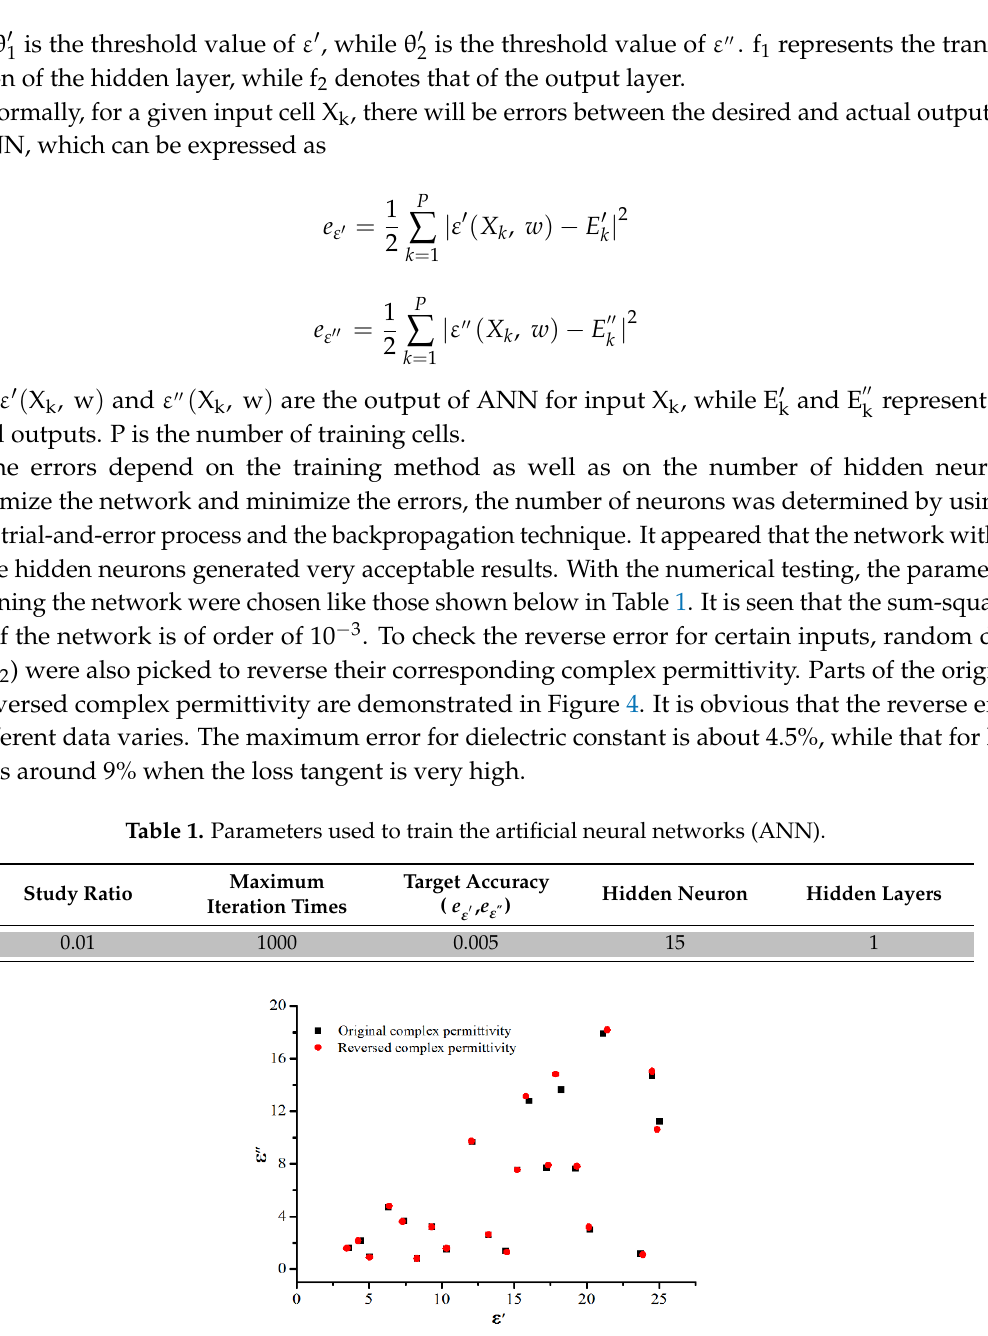
Figure 4. Comparison of the original and reversed complex permittivity.